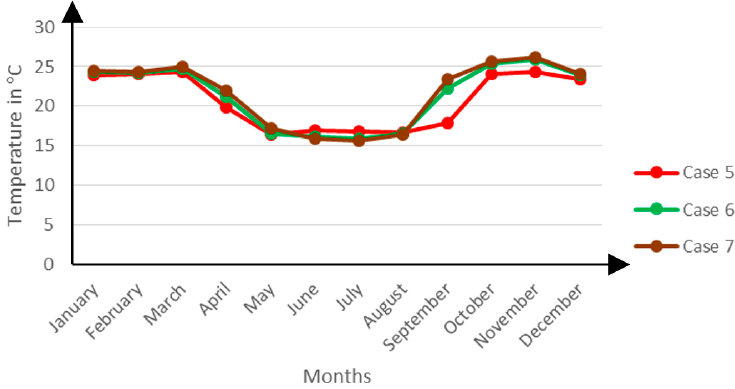
Figure 9. Monthly mean zonal temperature for Cases 5, 6 and 7.